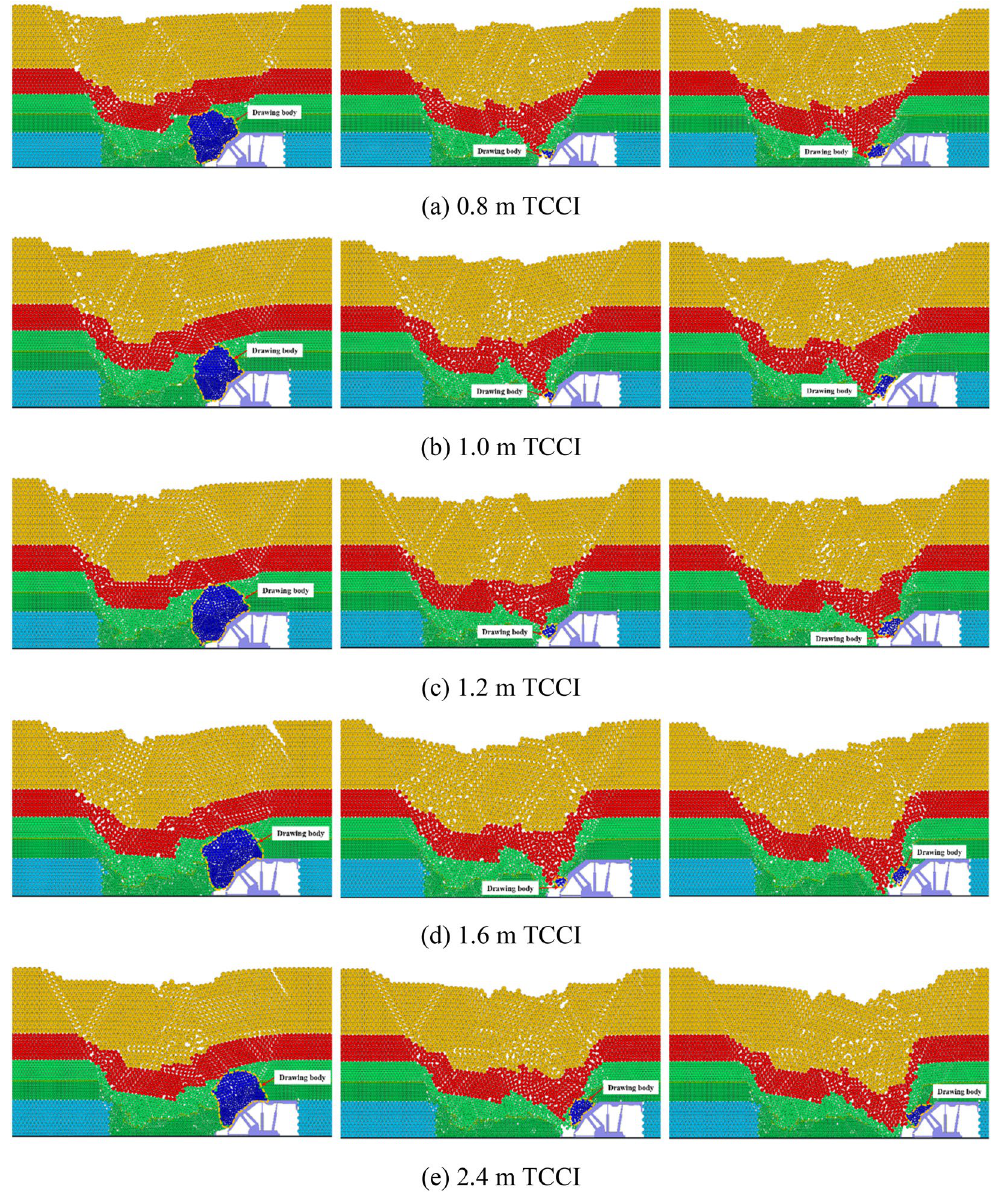
Figure 3. Inversion results of the first three top coal release body in different coal-drawing interval under 4.0 m top coal